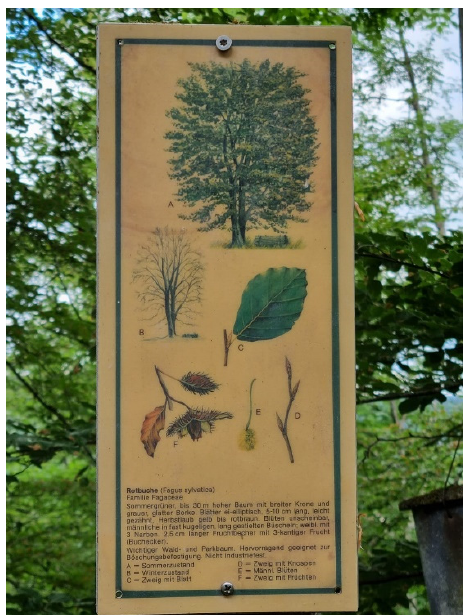
Figure 20. Panel not addressing the local conditions (Trail Gomadingen, Julian Stolz 2022).